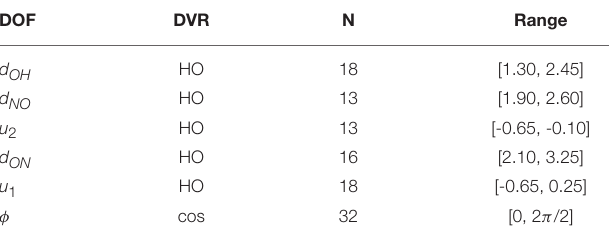
TABLE 3 | Definition of the MCTDH primitive grid: HO denotes a harmonic oscillator (Hermite) and cos a cosine Discrete Variable Representation (DVR) basis functions.